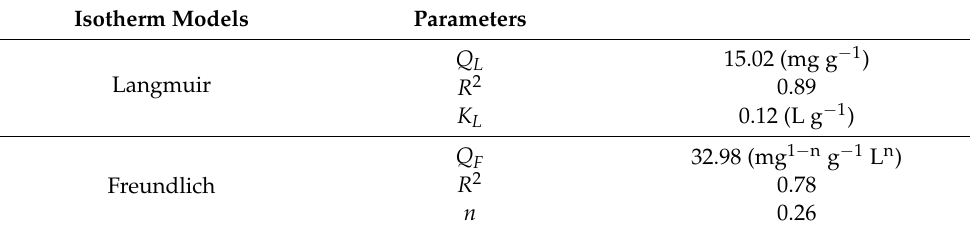
Table 1. Isotherm model values for chromium adsorption on the walnut shell